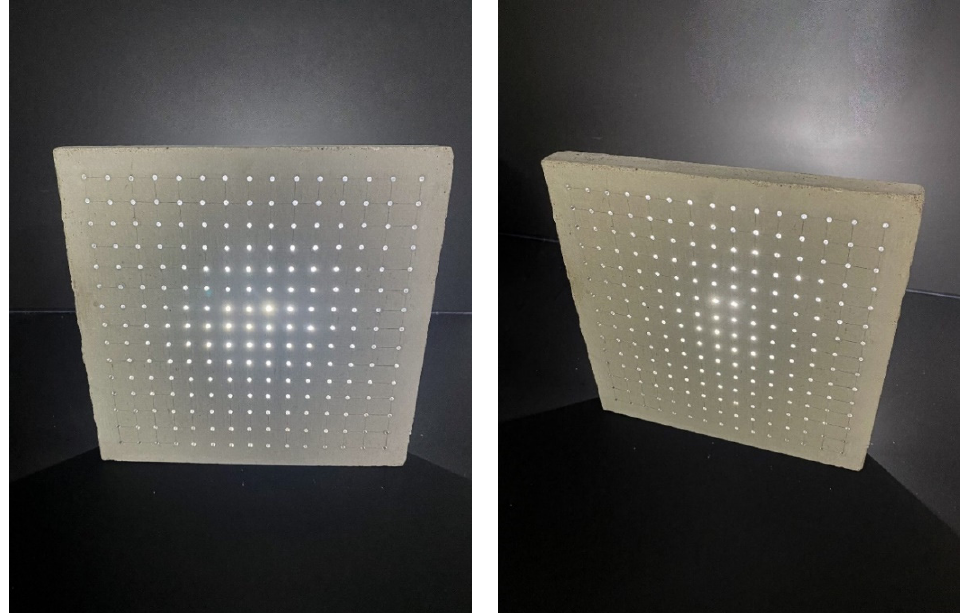
Figure 10. Concrete slab with optical fibers.